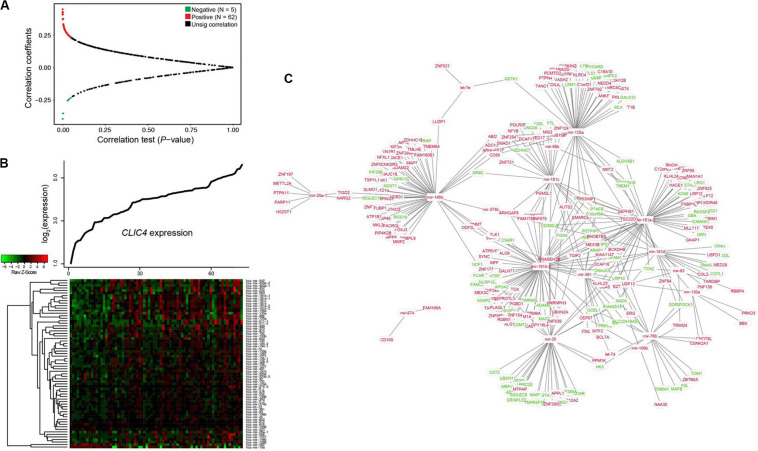
Interaction network analysis of genome-wide microRNAs and their target genes associated with CLIC4 expression. (A) Volcano plot of the genome-wide microRNA profiles between the CLIC4high and CLIC4low groups. (B) MicroRNA expression heatmap. The top curve indicates the expression distributions of CLIC4 in 73 cytogenetically normal acute myeloid leukemia (CN-AML) samples. (C) MicroRNA–mRNA interaction network analysis (red: upregulation; green: downregulation; rectangle: microRNAs; ellipse: mRNAs).